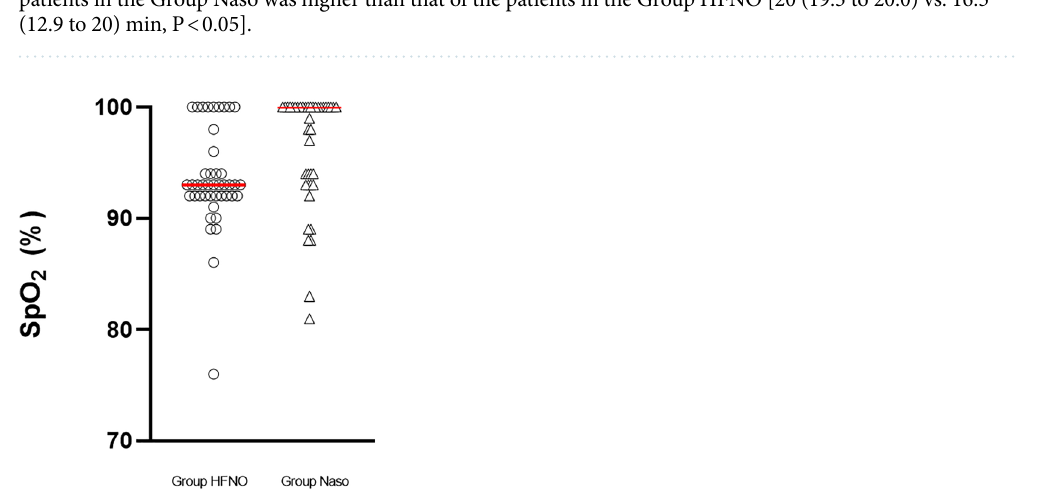
Figure 4. The lowest SpO 2 between the two groups, horizontal line = median. The lowest SpO 2 of the patients in the Group Naso was higher than that of the patients in the Group HFNO [100% (93% to 100%) vs. 93% (92% to 96%), P < 0.05].